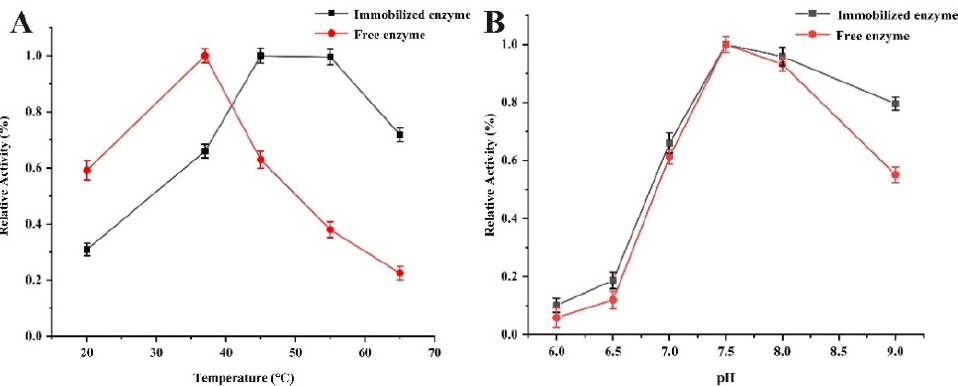
Figure 6. The effects of the temperature ( A ) and the pH ( B ) on the relative activity of free PPL and Fe 3 O 4 @UiO-66-NH 2 @PPL. Fe 3 O 4 @UiO-66-NH 2